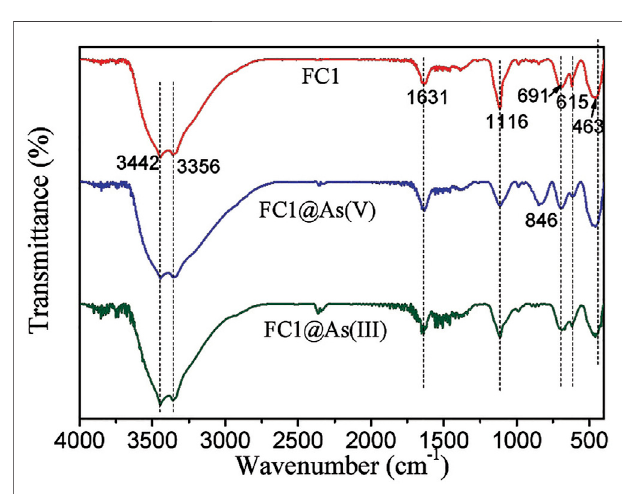
FIGURE8| FTIRspectraofFe-Cubinaryoxidesbeforeandafterarsenic adsorption. Initial arsenic concentration (cid:2) 10 mg/L, adsorbent dose (cid:2) 200 mg/L, pH (cid:2) 7.0 ±